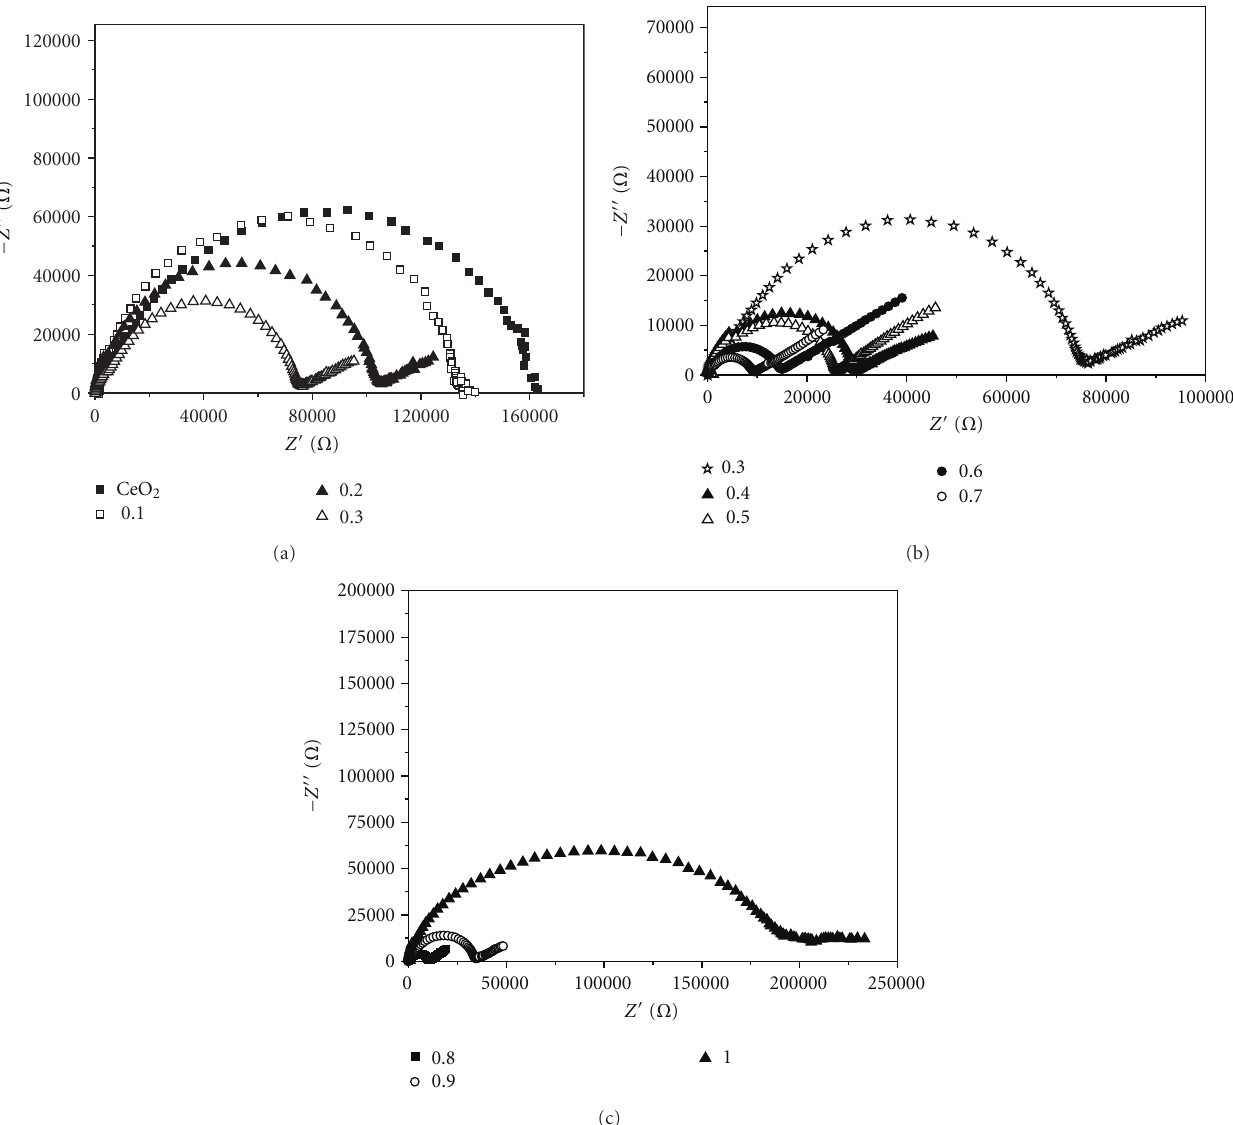
Figure 3: Nyquist plots of impedance analyses at 400 ◦ C for the system (1 − x )CeO 2 · ( x/ 2)Bi 2 O 3 . Depletion angles of Nyquist circles are visible. The low-frequency signals are associated with Warburg-like behaviors. (a) 0 < x < 0 . 3; (b) 0 . 3 < x < 0 . 7; (c) 0 . 7 < x < 1.